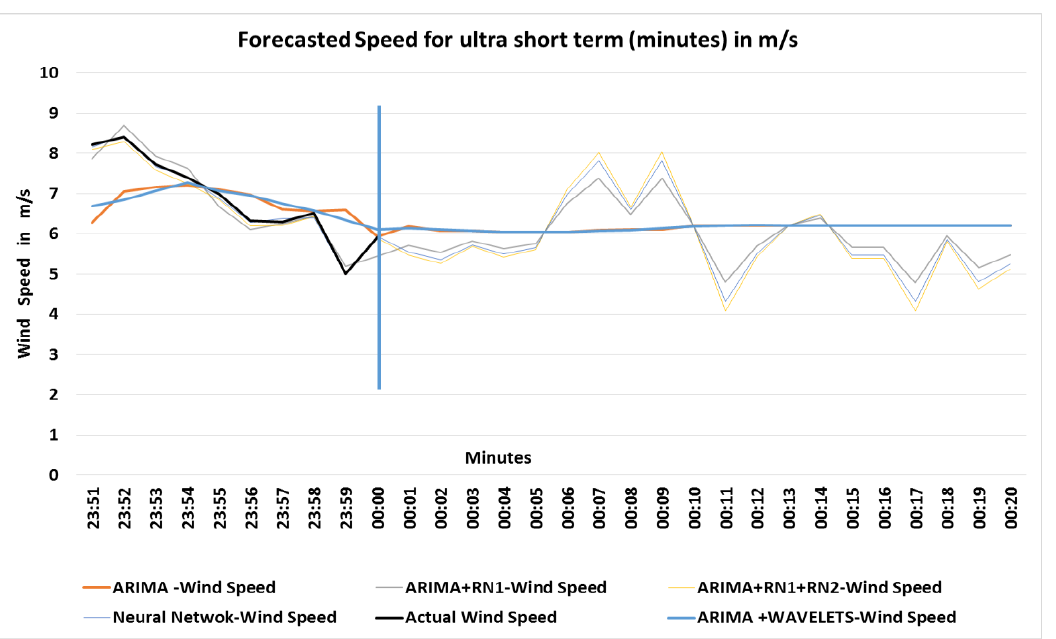
Figure 9. Generated power expected for ultra-short term (minutes) in KW. The forecast for this horizon takes into account an ultra-short time interval, which produces some abrupt changes in the speed variation. From the interval of 5 min to 7 min, there was an increase of approximately 15 kW according to the forecast ARIMA + NN1 + NN2, and a drop of approximately 20 kW from the range of 9 min to 11 min. After these peaks, forecasting tended to an average of approximately 10 kW and the ARIMA model tended to 12 kW. There were peaks in the prediction of up to 26 kW. The forecast of power generation for this horizon is important for electricity market compensation, real-time network operations and regulatory actions.